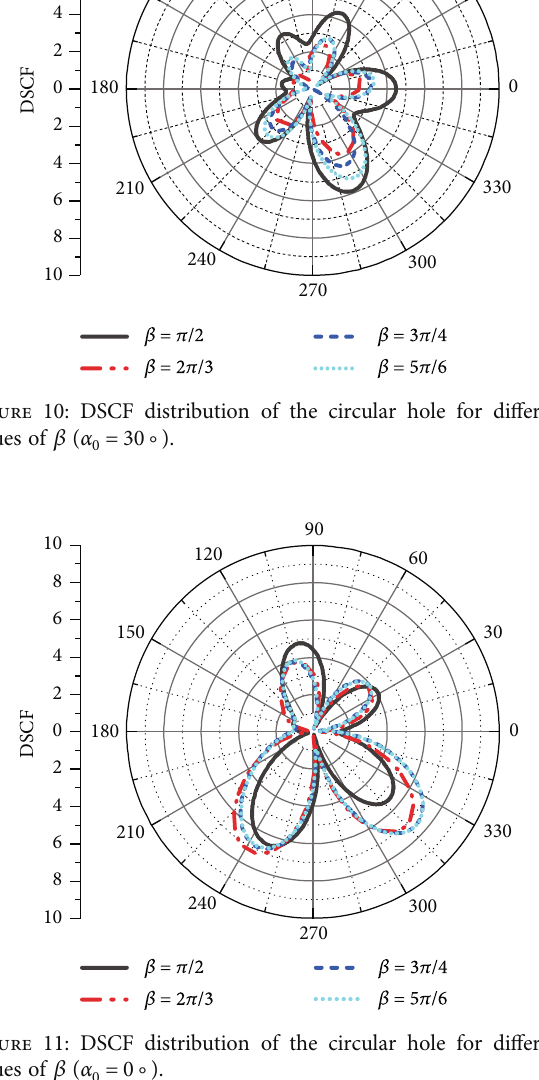
hole are randomly selected. The shape parameters of the wedge space are set to β = 2 π /3 , b = 1 : 0 , a = b / = b = 1 : 0 . According to Figure 5, when the position r 2 parameters of the circular hole are d / r 2 = 8 : 0 and h / r 2 = 7 : 0